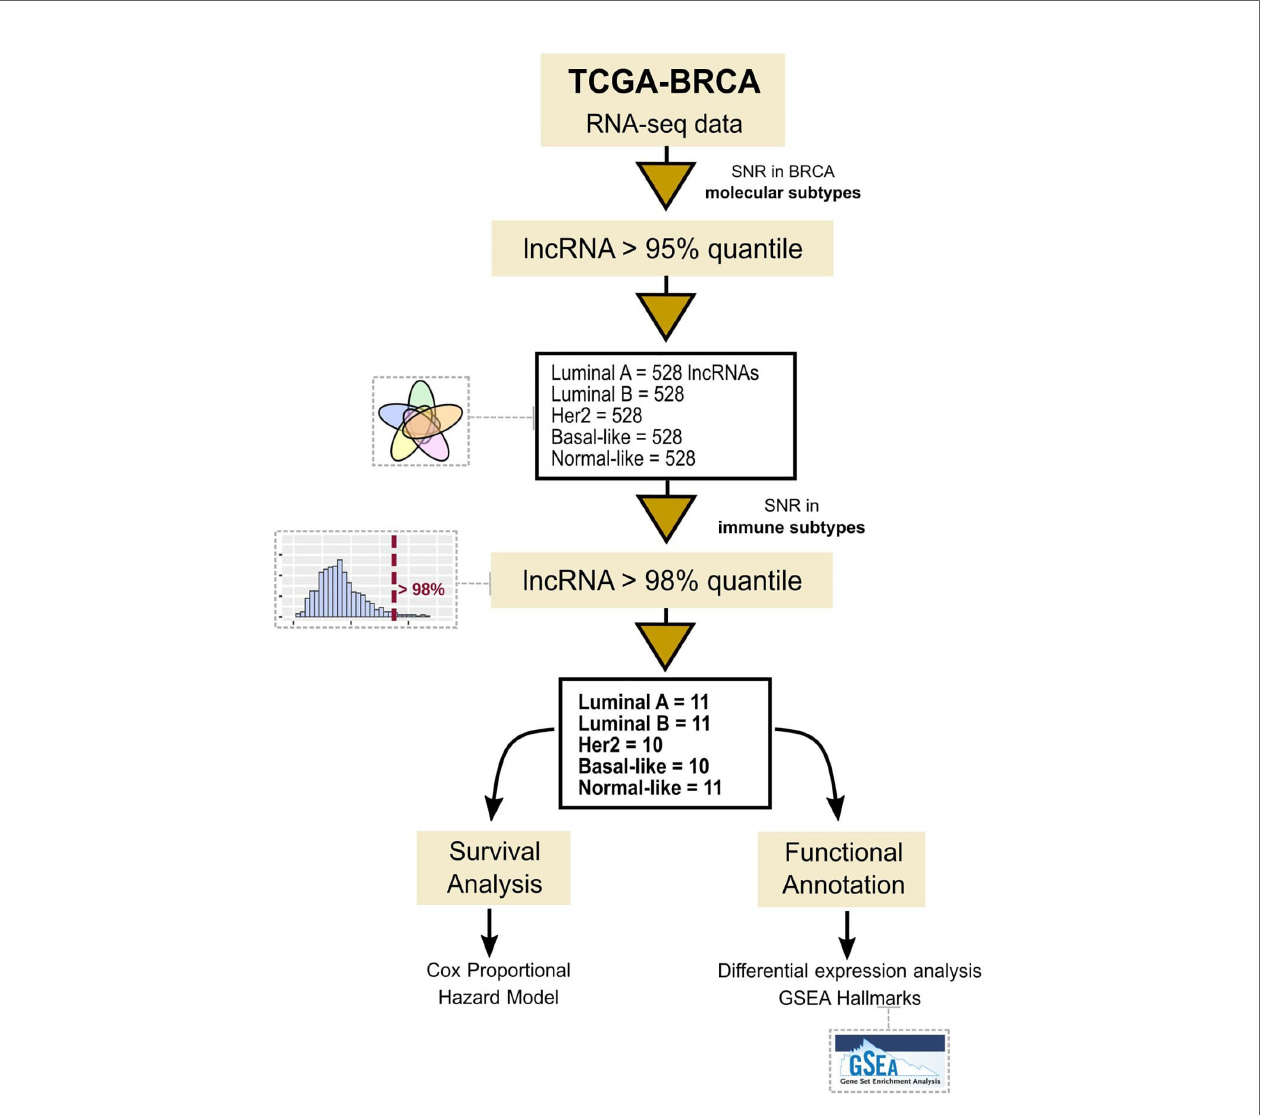
FIGURE 1 | Work fl ow representation of the used methodology to study immune-related